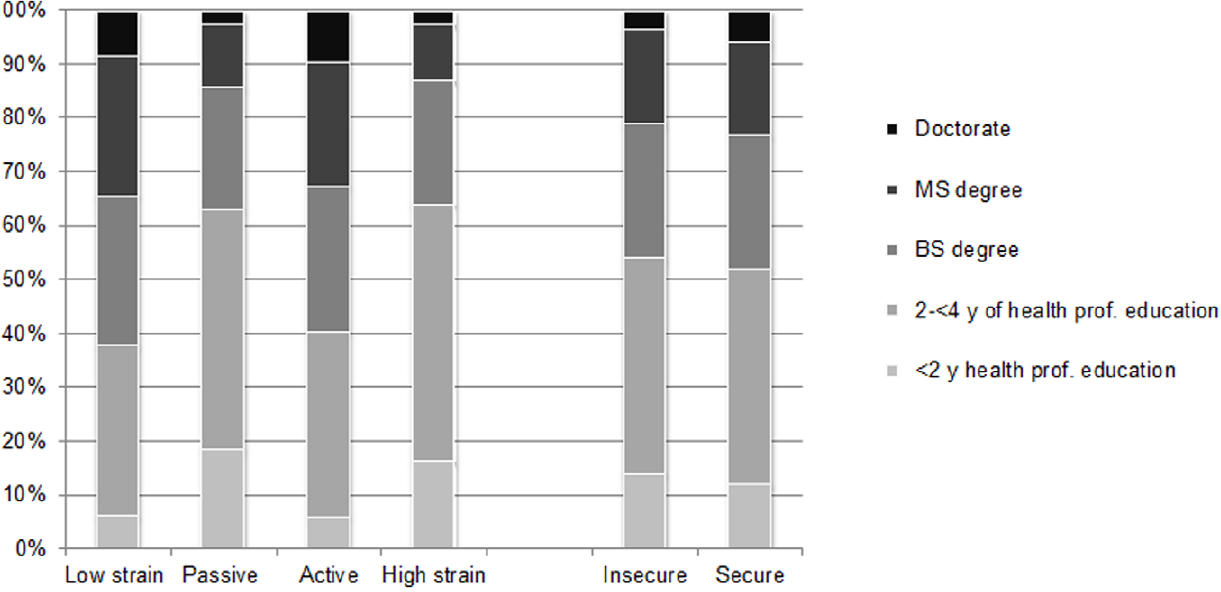
Figure 1. Education Level according to Job Strain and Job Insecurity Categories among Women Health Study Participants (N=22,086).